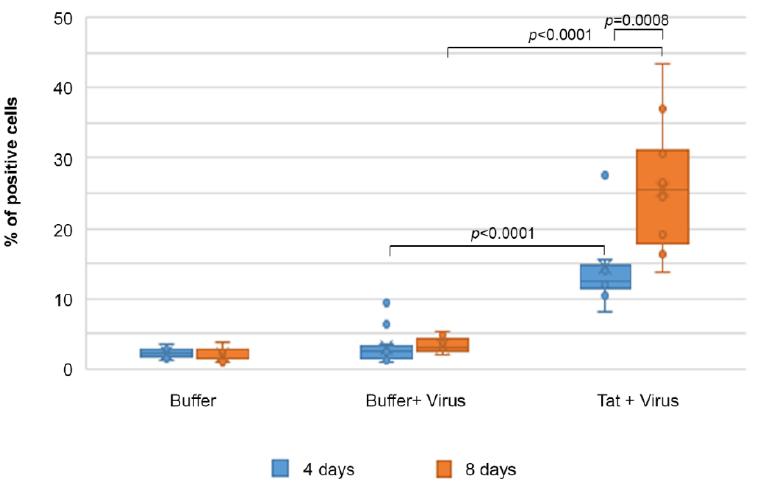
Figure 7. Extracellular Tat protein promotes productive HIV-1 infection of IC-HUVEC. IC-HUVEC were exposed to NL4.3 virus (p24-Gag = 70 ng/mL) in the absence or in the presence of 10 μg/mL of biologically active Tat protein (Tat). Four and 8 days later, cells were washed, trypsinized, and processed for intracellular staining for p24-Gag antigen. Box–plot of data obtained from five independent experiments and analyzed by the Wilcoxon Two-sample Test are shown. Dots indicate individual measures.